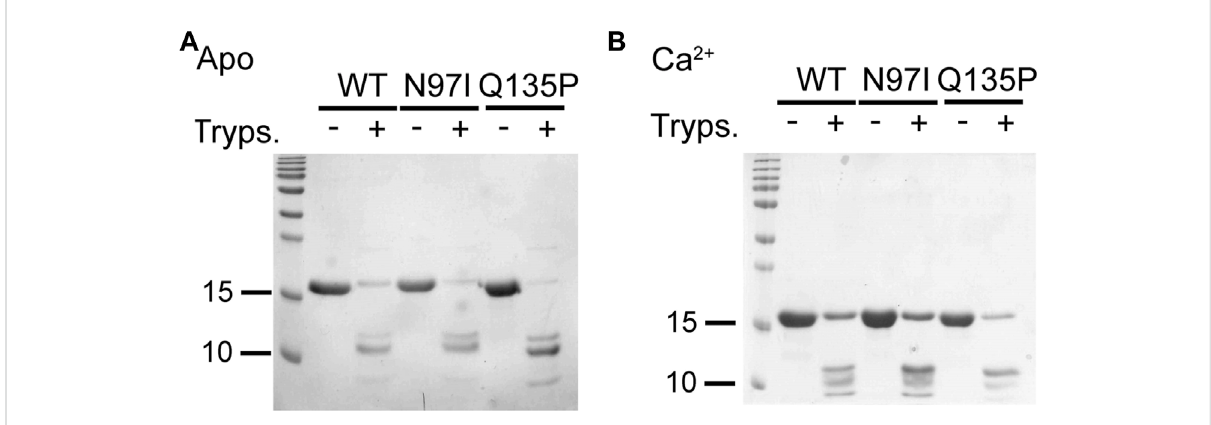
FIGURE 3 Limited proteolysisofCaM variants. CaMvariants (26.6 µM)wereincubatedwith .4 µMtrypsin(ratio1:66trypsin: CaM)in thepresence of2 mM EGTA (A) or Ca 2+ (B) . Reactions were run for 10 min at 25 ° C and then blocked by boiling samples for 10 min at 96 ° C. Proteolytic fragments were loaded on a 15% SDS-PAGE and Coomassie blue-stained. For each investigated condition, the untreated protein was loaded as a